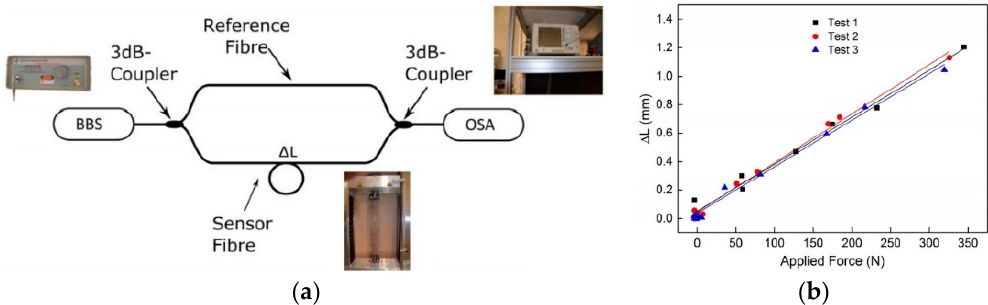
Figure 8. Fiber optic Mach-Zehnder set-up to measure and characterize the strain transfer between a textile-based carbon reinforcement structure and the optical glass fiber: ( a ) Experimental set-up and ( b ) obtained sensor response [51].